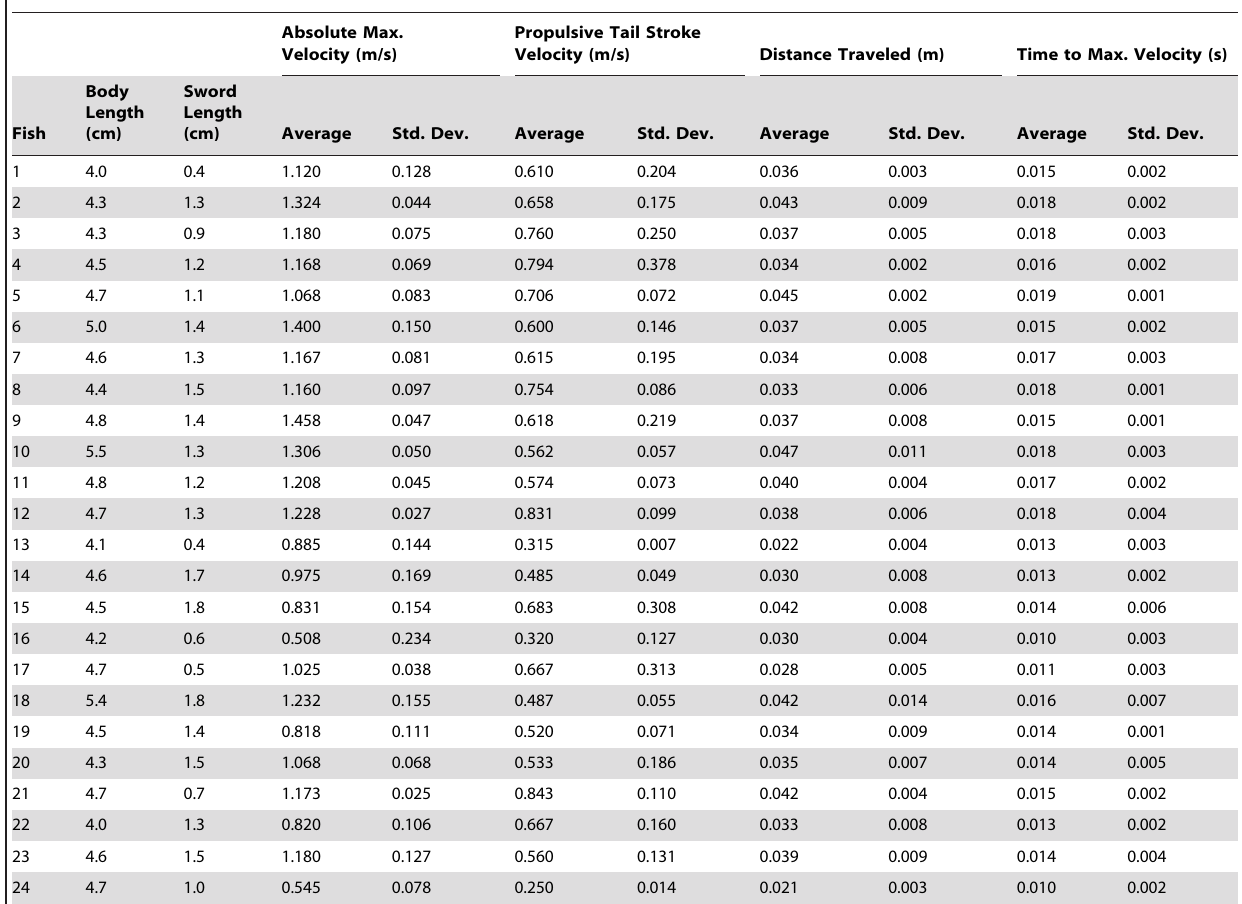
Table 1. Morphological and performance data for the 24 X. helleri males used in this